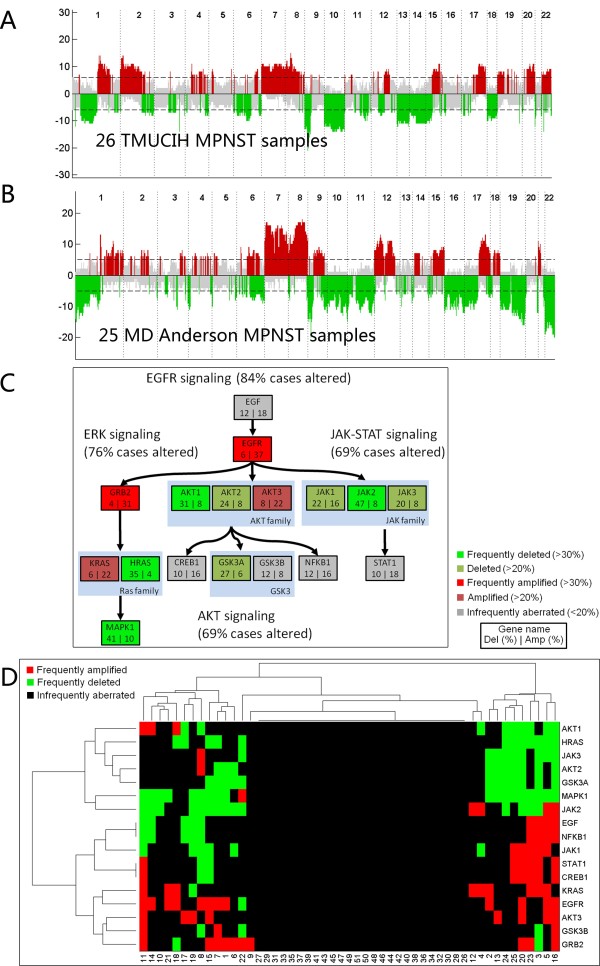
Copy number alterations in 26 MPNST samples from Tianjin Medical University Cancer Institute & Hospital (TMUCIH) and 25 MPNST samples from MD Anderson Cancer Center and genetic amplifications of the EGFR signaling pathway, including those of the EGFR gene itself. (A,B) Recurrent gene copy alteration patterns in 26 MPNST from TMUCIH patients (A) and 25 MPNST from MD Anderson Cancer Center patients (B). The x-axis numbered with 1–22 denotes chromosome numbers. The y-axis shows recurrence of gains (positive axis) and losses (negative axis) for each measured locus evenly distributed in chromosomal order. Recurrence rates that exceed the threshold (dashed line) are color-coded to emphasize the locations of significantly recurrent aberrations. Red denotes significantly recurrent amplifications and green denotes significantly recurrent deletions. Gray represents nonsignificant recurrence of aberrations. (C) Aberration rates of EGFR signaling pathway genes in all 51 MPNST samples. The number on the left side is the deletion frequency (Del) of the gene, and the number on the right side is the amplification rate (Amp). Color-coding indicates the type and frequency of aberration (red amplified, green deleted). (D) Hierarchical clustering of aberrations of EGFR signaling pathway genes in all 51 MPNST samples showed a panoramic view of genetic aberrations in EGFR signal pathway. Red means amplification and green means deletion.